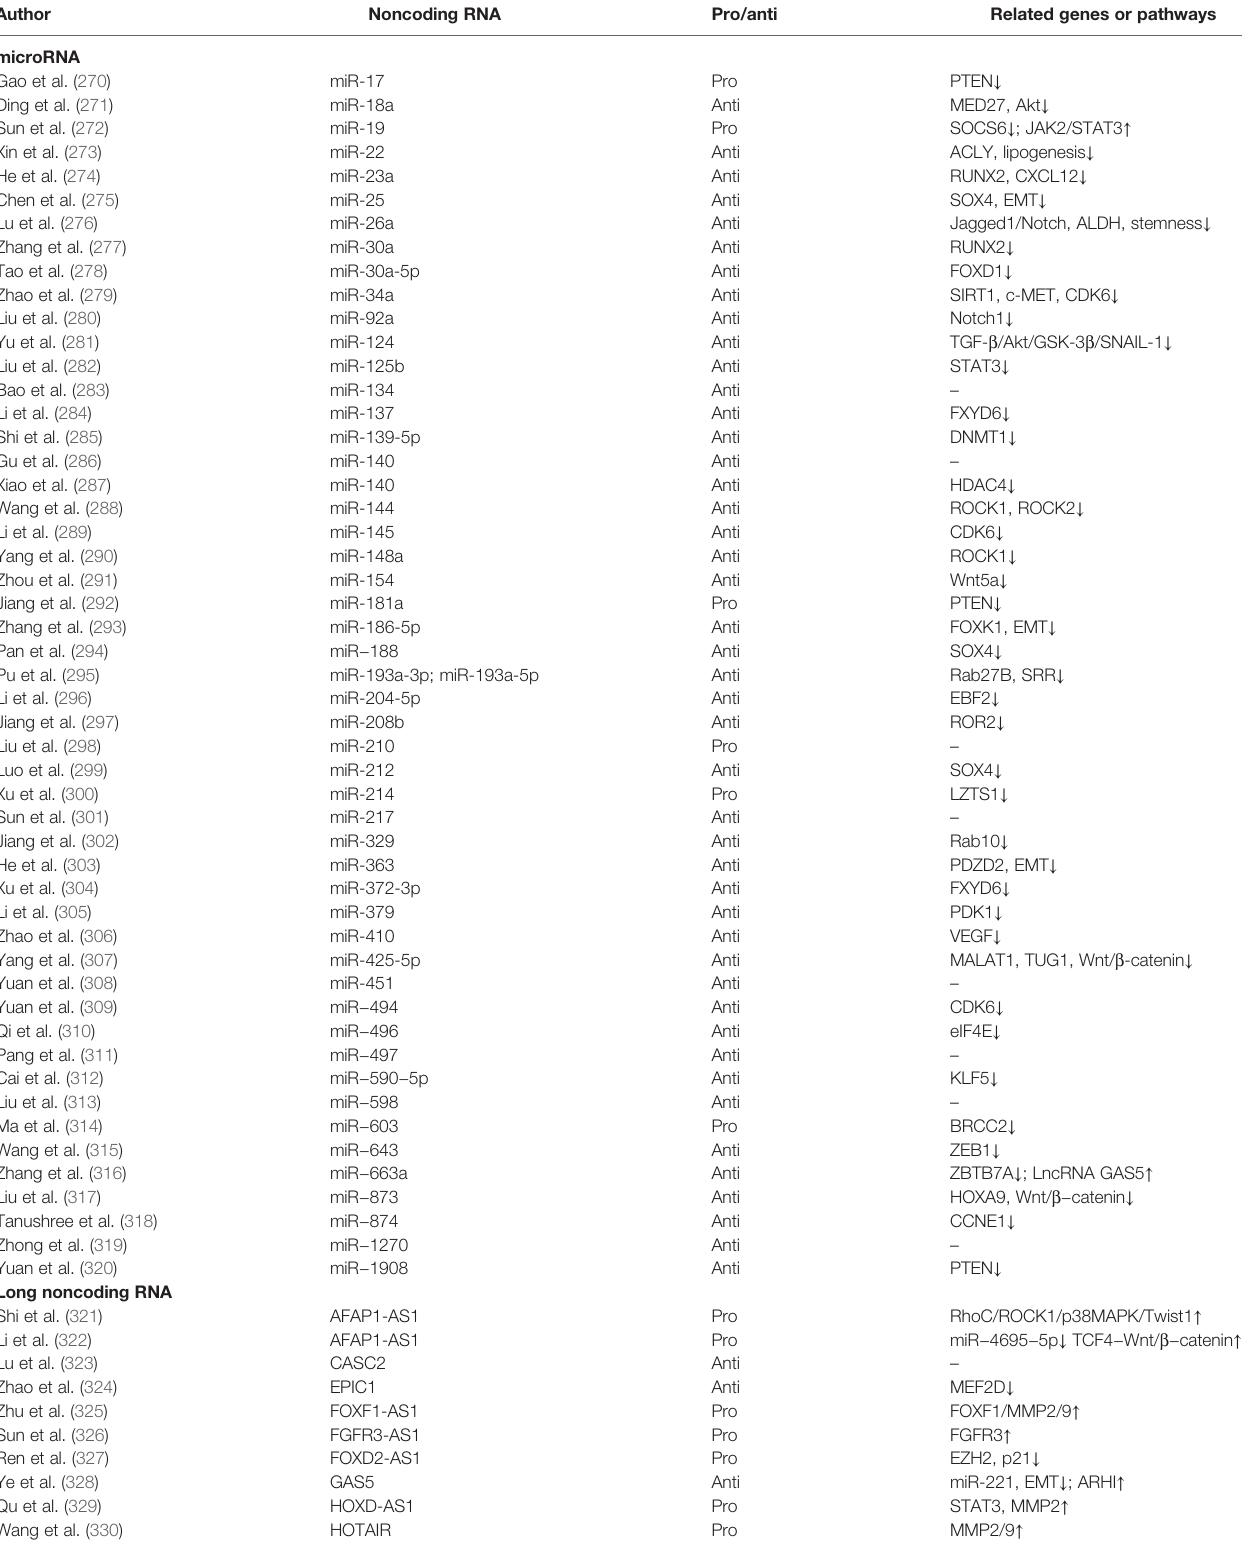
TABLE 2 | Summary of noncoding RNAs involved in osteosarcoma